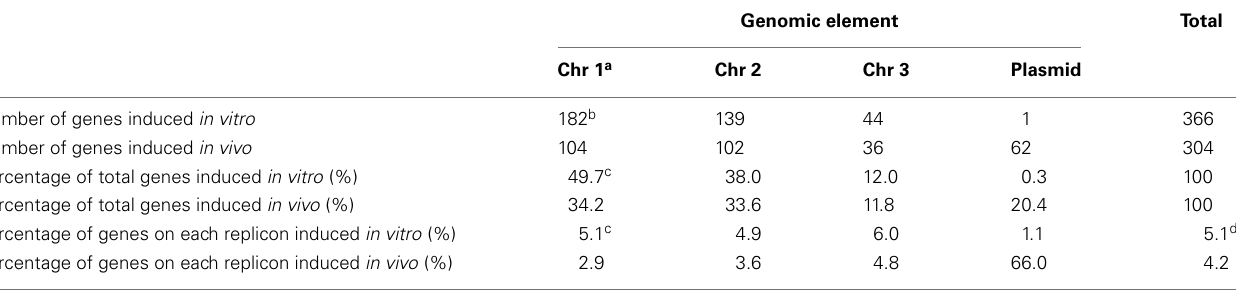
Table 2 | Microarray analysis of B. cenocepacia genes induced in vitro or induced in vivo .